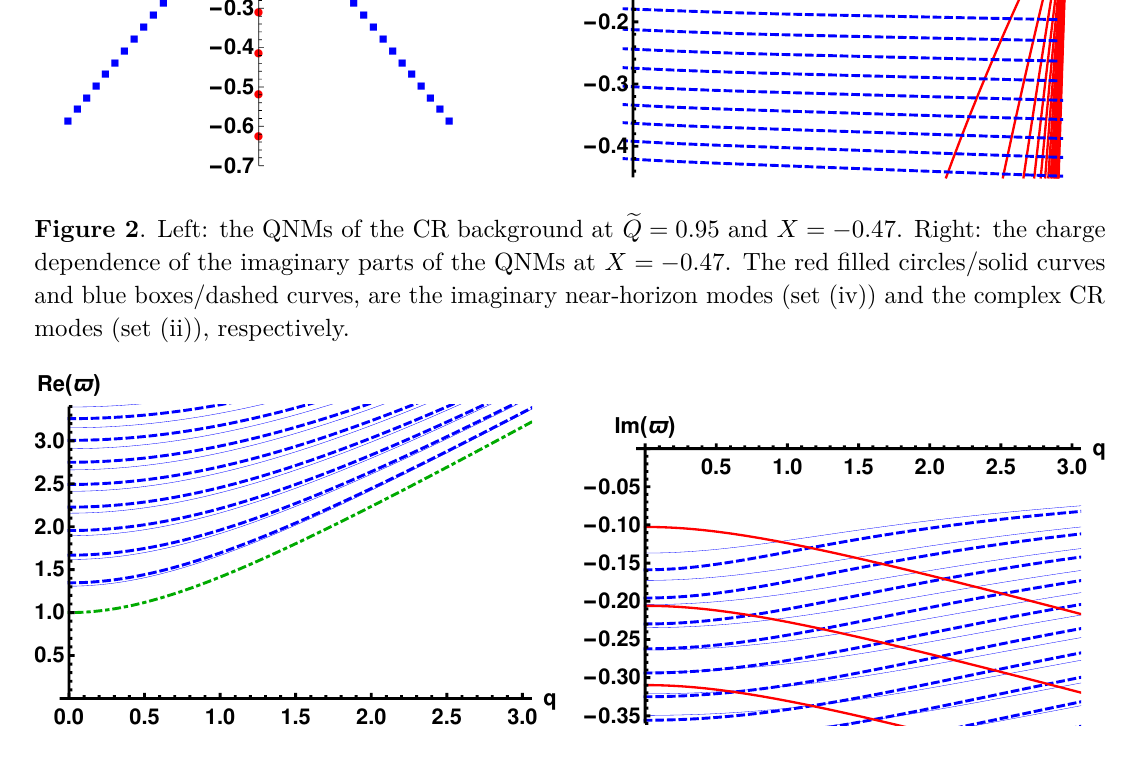
Figure 3 . The dependence of the QNMs of the CR background on q at X = − 0 . 47 . The thick dashed blue and thick solid red curves show our result at e Q = 0 . 95 and the thin solid curves are the result at e Q = 0 for comparison. The red curves and blue curves are the imaginary near-horizon modes and the complex CR modes, respectively. Left: the real parts of the QNMs. The green dotdashed curve is the “critical” line Re $ = p 1 + q 2 . Right: the imaginary